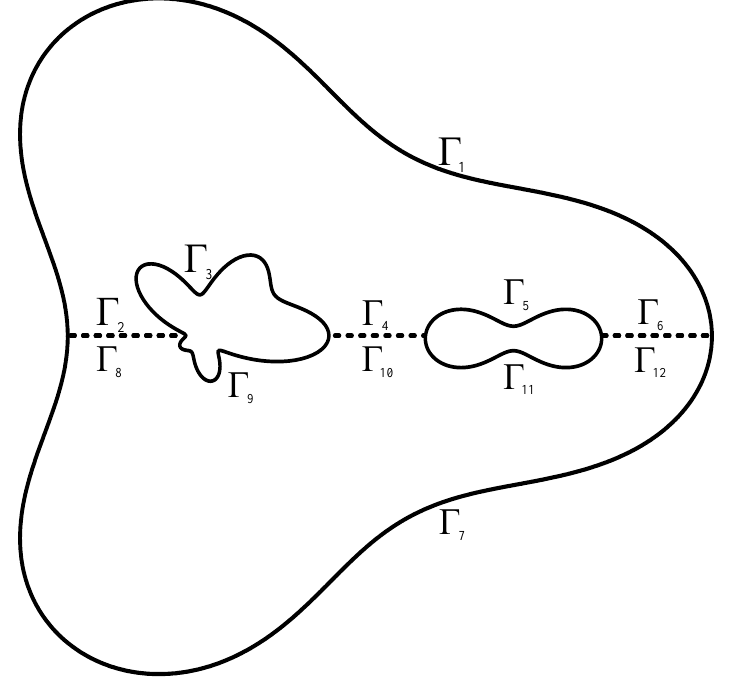
Figure 15. Configuration of sub-boundaries.